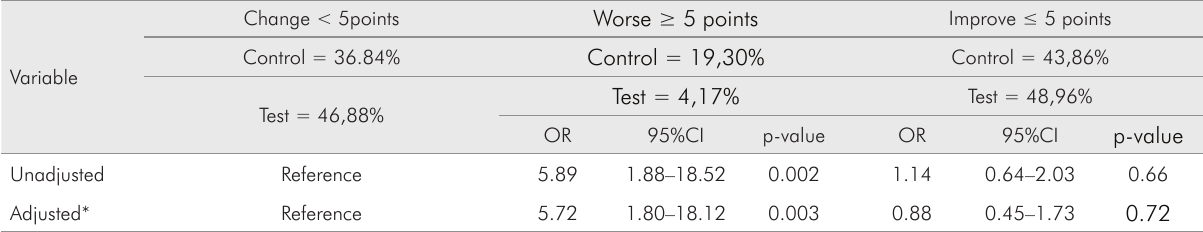
Table 3. Uni and multivariable analysis (multinomial logistic regression) for OHIP-14 change and absent of non-surgical periodontal